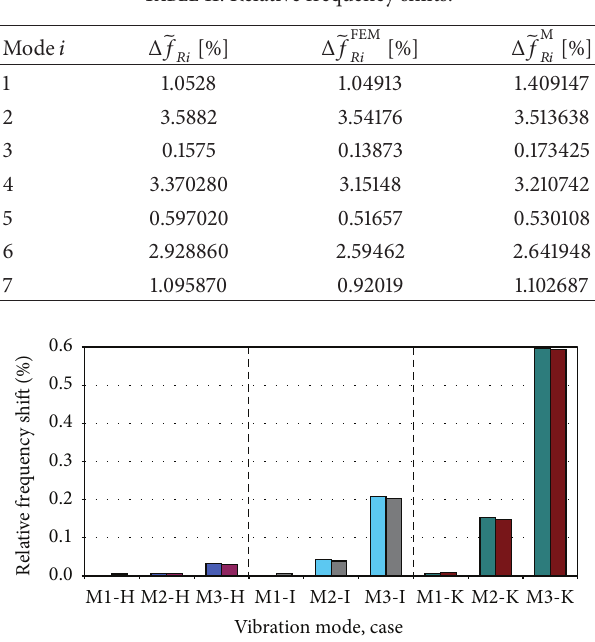
Table 11: Relative frequency shifts.